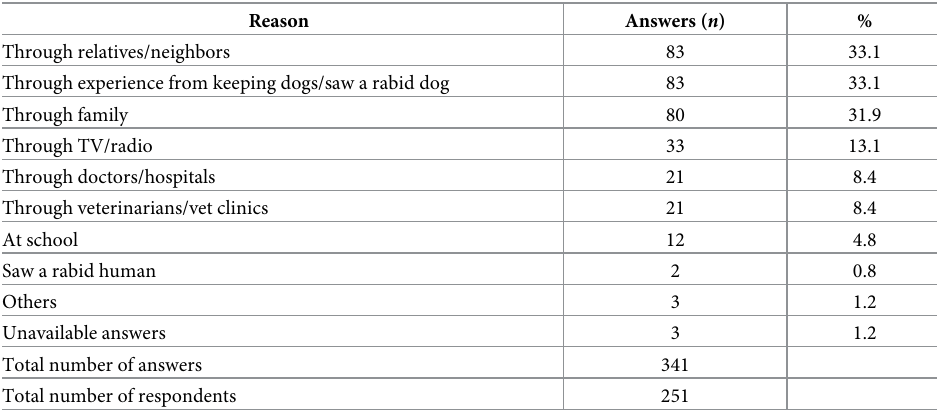
Table 6. Sources of information about rabies (multiple answers).